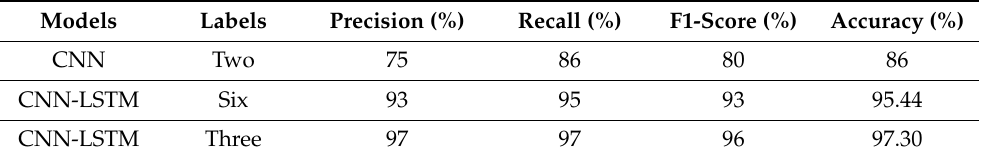
Table 11. Comparison results of deep learning algorithms.